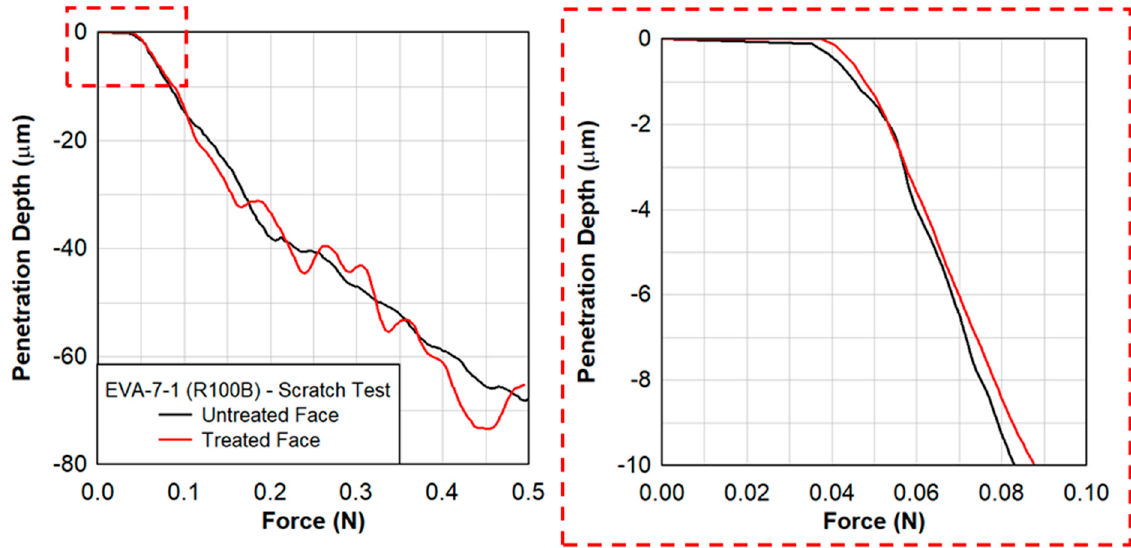
Figure 17. Scratch testing on EVA − 7 − 1 showing the penetration depth as a function of force applied at a scratch rate of 20 mm/min.